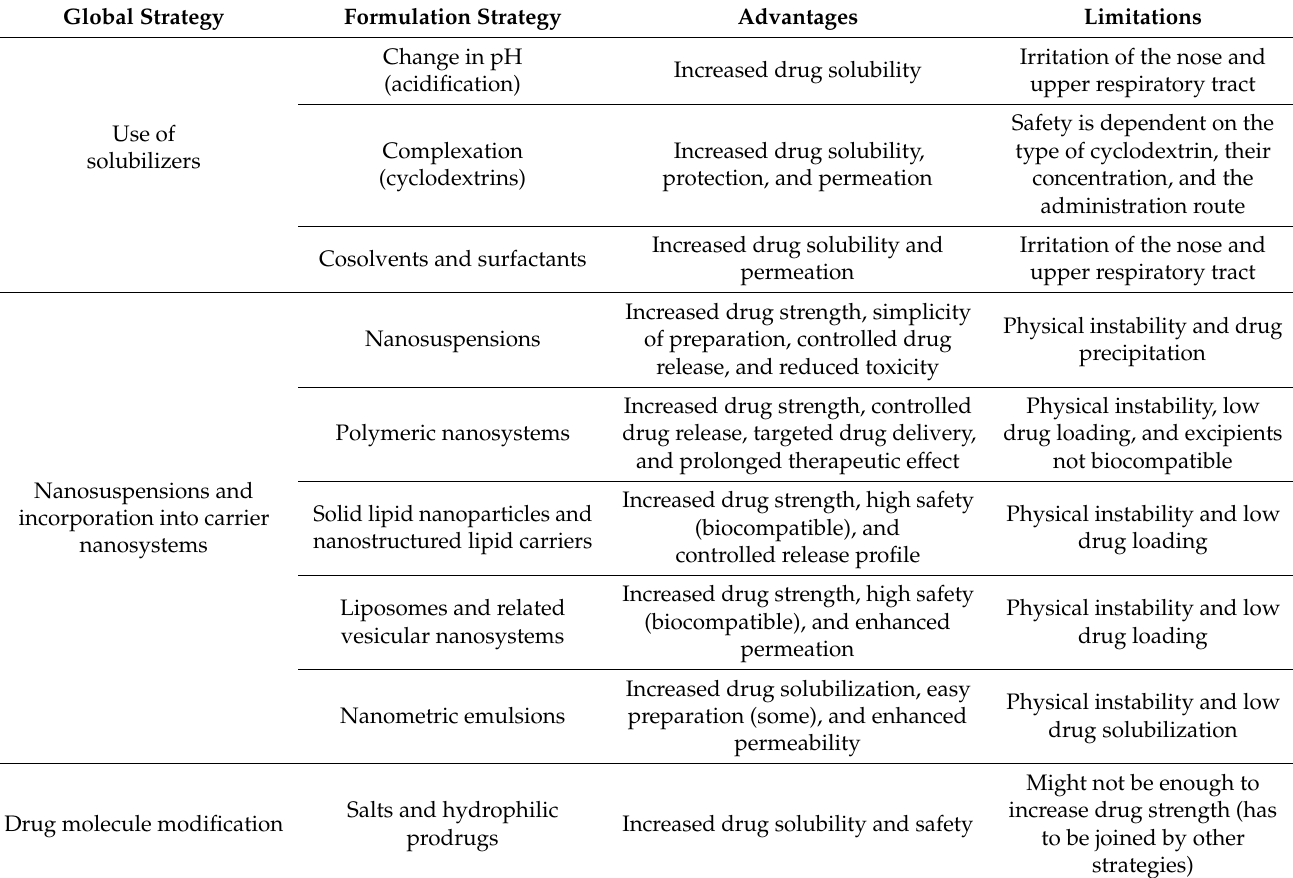
Table 2. Advantages and limitations of formulation strategies for increasing drug strength of low water solubility drugs in liquid nasal